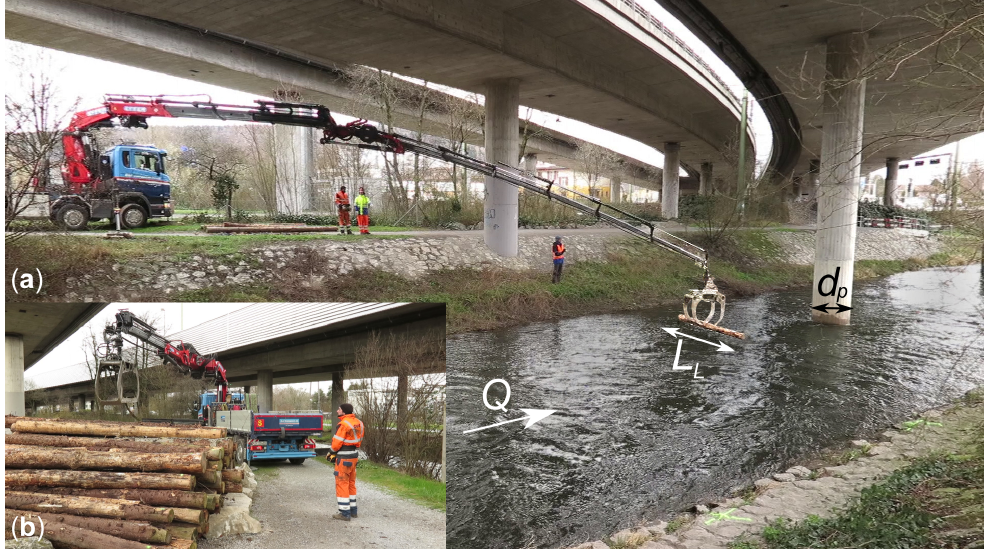
Figure 2. ( a ) Test site at the River Glatt with a log being placed upstream of the bridge pier by a truck crane with discharge Q , log length L L , and pier diameter d p , and ( b ) log storage prior to the log placement in the river.